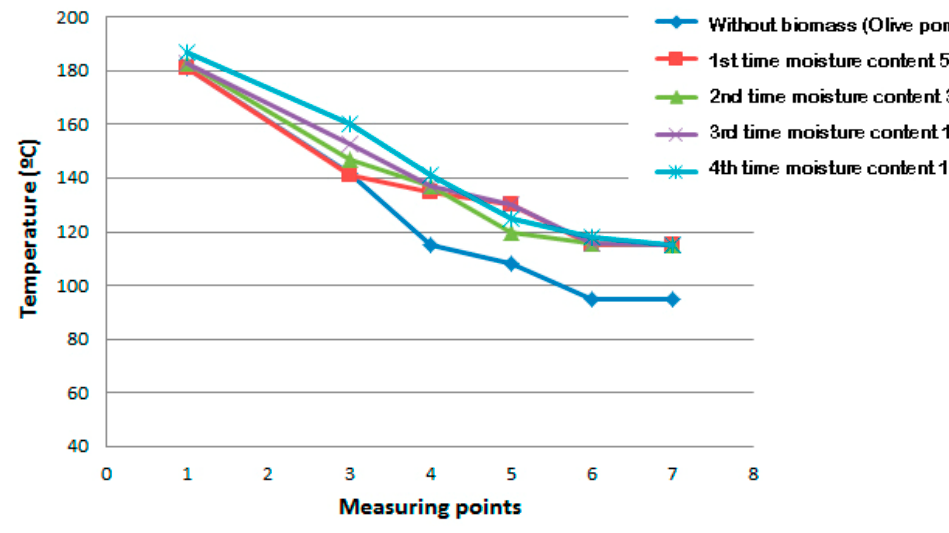
Figure 6. Temperature profile inside the dryer in the case of olive pomace.